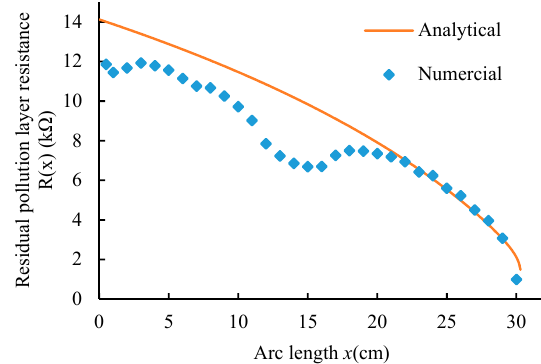
Figure 10. Comparison of R ( x ) between numerical values and analytical calculation.